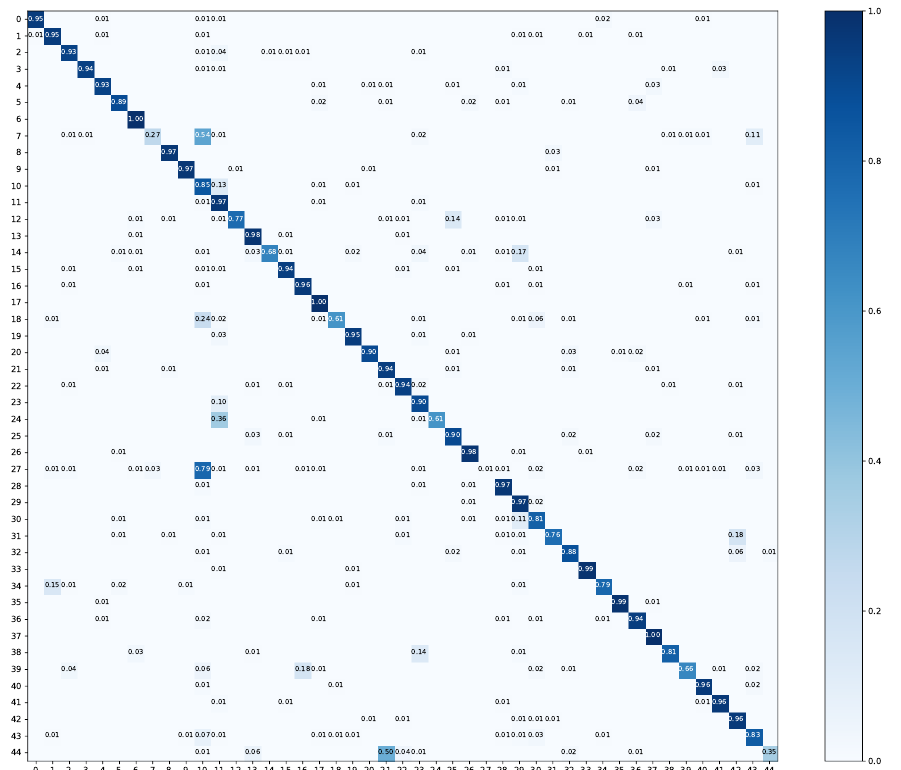
Figure 6. Confusion matrix obtained by our proposed method on NWPU-RESISC45 testing set.